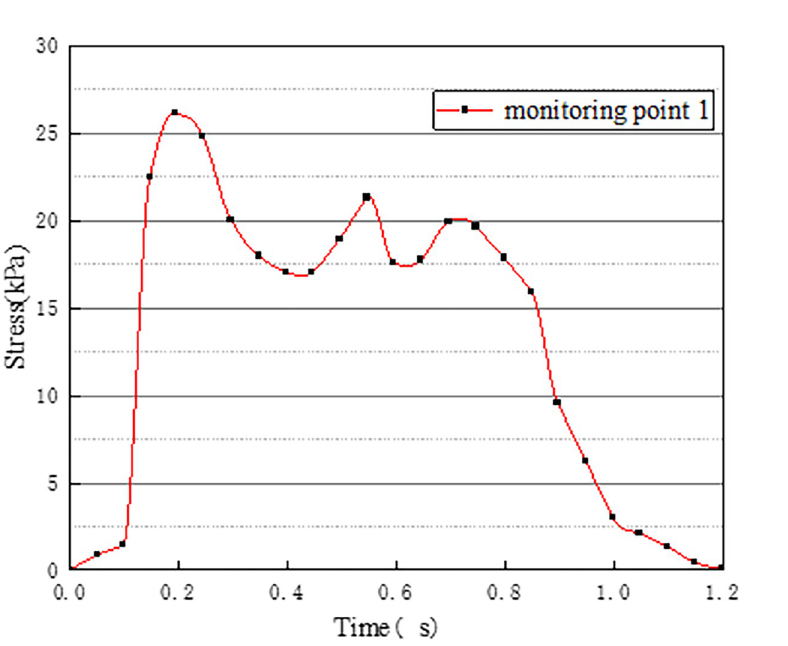
Fig 3. Stress time history curve of monitoring point 1.